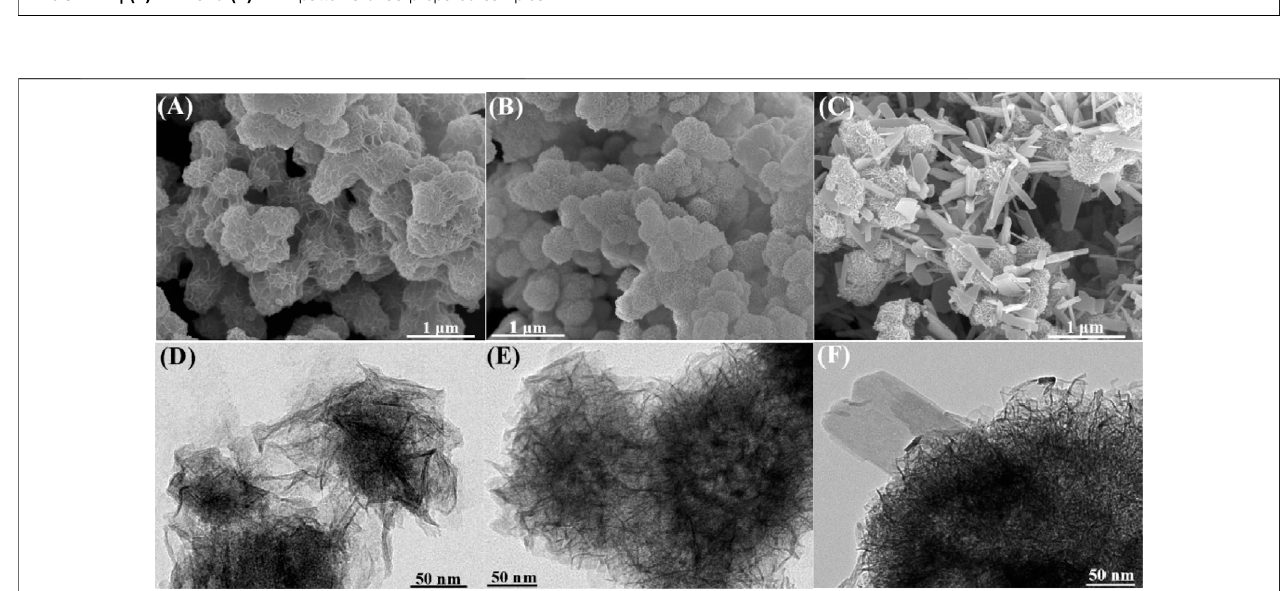
FIGURE 3 | SEM and HRTEM images of (A,D) BF-1.50, (B,E) BF-1.85 and (C,F) BP-2.0.